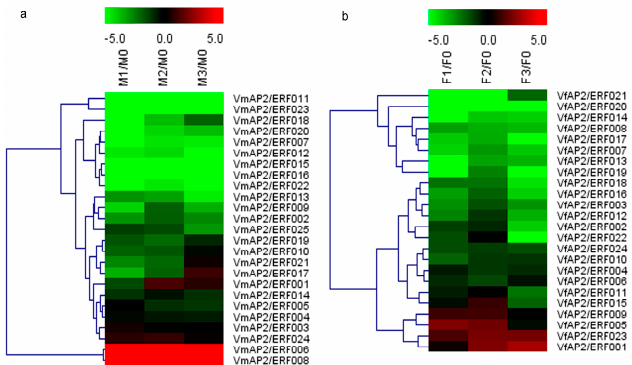
Figure 3. Expression profiles of dehydration ‐ responsive element ‐ binding (DREB) subfamily genes in response to Fusarium oxysporum in Vernicia , namely ( a ) VmDREB subfamily; and ( b ) VfDREB subfamily. The heat map depicts expression patterns of DREB subfamily genes in V. fordii and V. montana in response to F. oxysporum at four infection stages: 0, uninfected stage; 1, early stage of infection; 2, middle stage of infection; 3, late stage of infection. Color scores were normalized by log2 ‐ transformed fold ‐ change values in the treated sample when compared with control sample. The data were generated by averaging the fold change from each of the three biological replicates’ reads per kilobase per million mapped reads (RPKM) values. The color scale is shown at the top. Red represents upregulation and green represents downregulation.